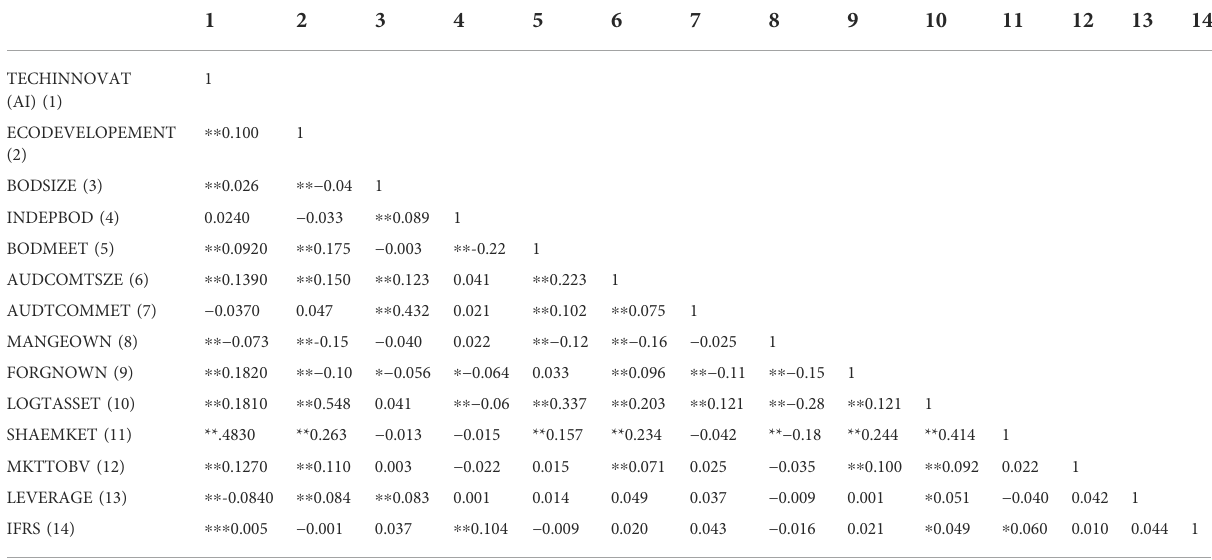
TABLE 2 Pearson ’ s correlation